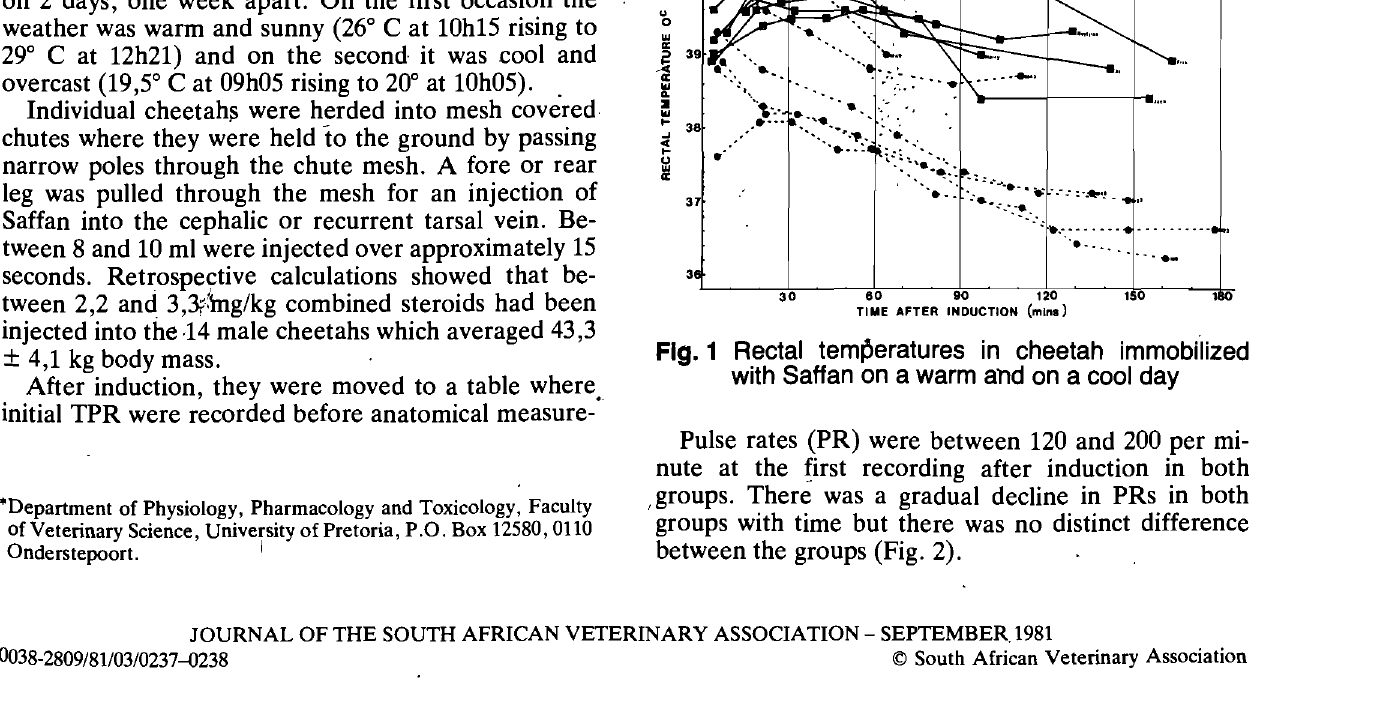
FIg. 1 Rectal tem~eratures in cheetah immobilized with Saffan on a warm and on a cool day Pulse rates (PR) were between 120 and 200 per mi nute at the first recording after induction in both ,groups. There was a gradual decline in PRs in both groups with time but there was no distinct difference between the groups (Fig.